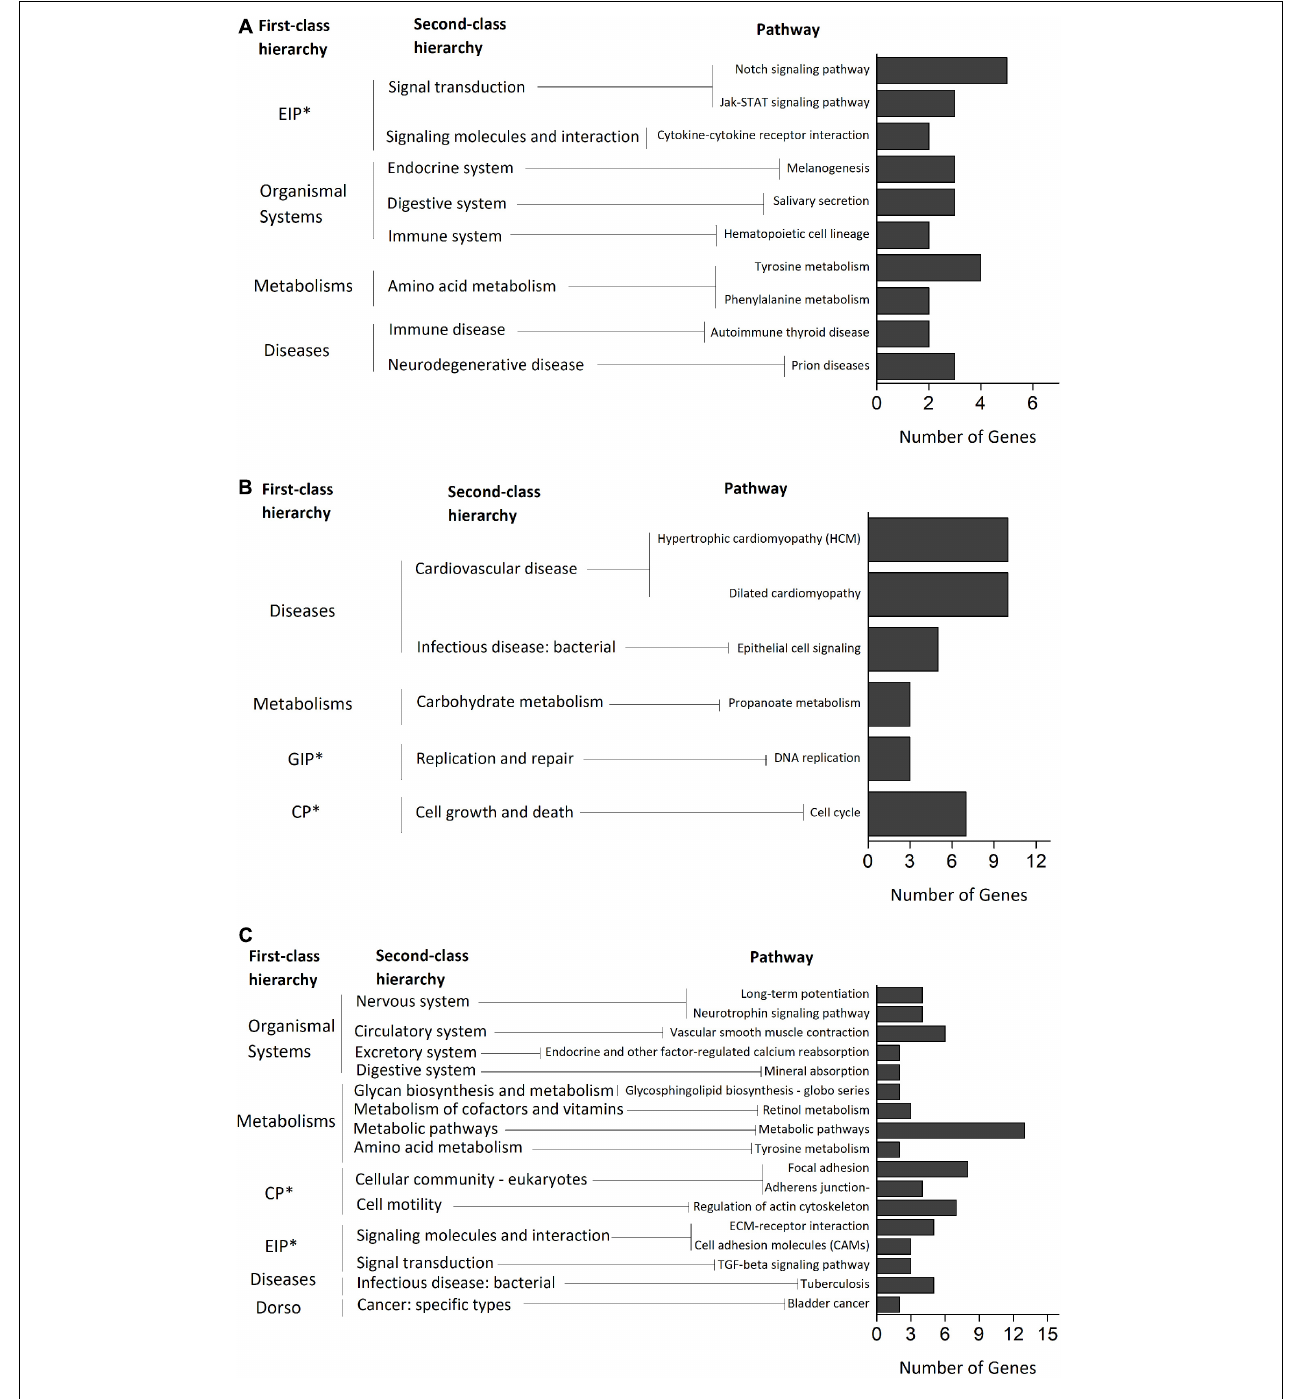
FIGURE 7 | KEGG pathway enrichment of the (A) ELD-J pairs genes, (B) ELD-T pairs genes, and (C) ELOD/ELUD pairs genes. ∗ EIP, environmental information processing; GIP, genetic information processing; CP, cellular processes.